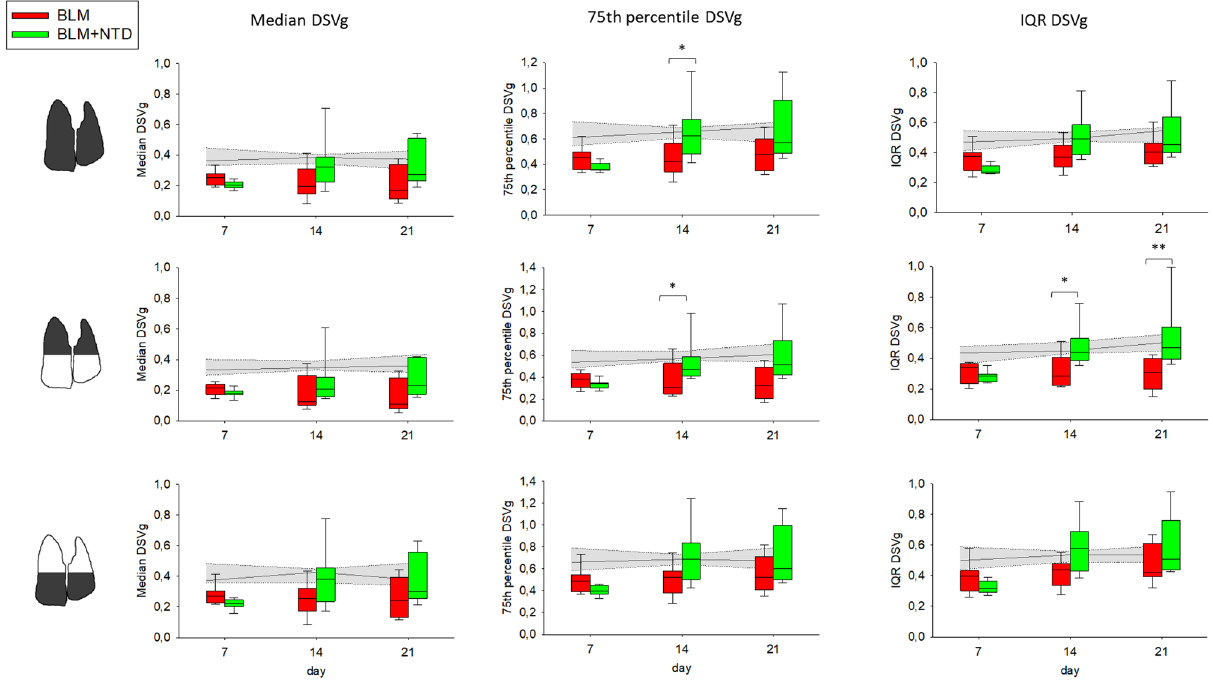
Figure 5. Median (first column), 75th percentile (second column) and IQR (third column) of DSVg, in the BLM (red) and BLM + NTD (green) group. The analysis was performed separately for the overall lung (top row), upper lung regions (middle row) and lower lung regions (bottom row). Gray area represents the saline values and is delimited by the 25th and the 75th percentile.